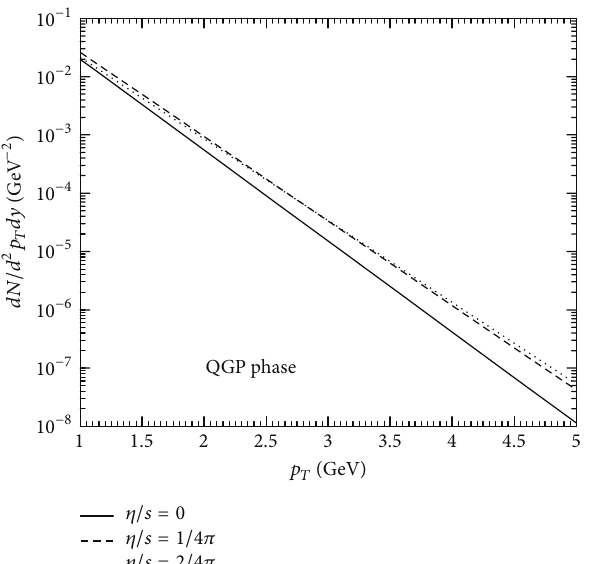
Figure 14: Transverse momentum distribution of photons from thermal hadrons for various values of 𝜂/𝑠 in the scenario (ii).